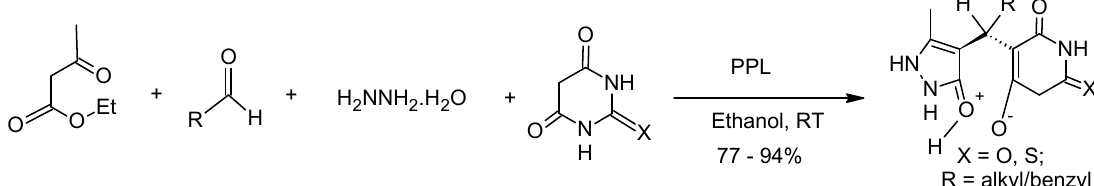
Scheme 21. Porcine pancreas lipase (PPL)-catalyzed 4-component synthesis of pyrazalone derivatives.